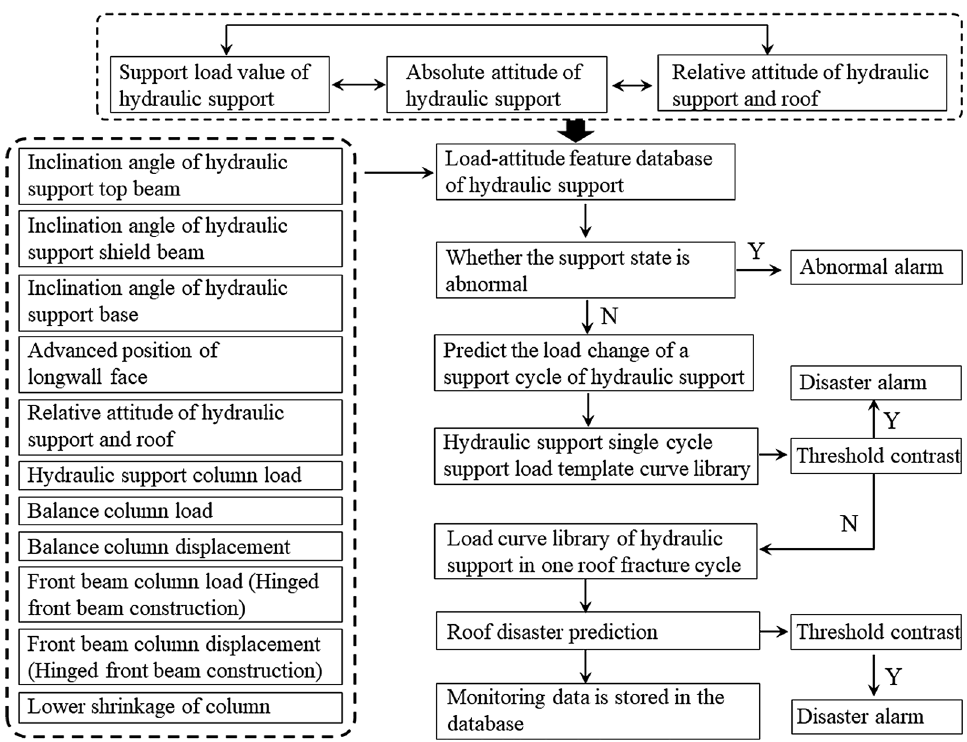
Fig. 14 Sequence of the support load template curves for one fracture cycle of the roof strata